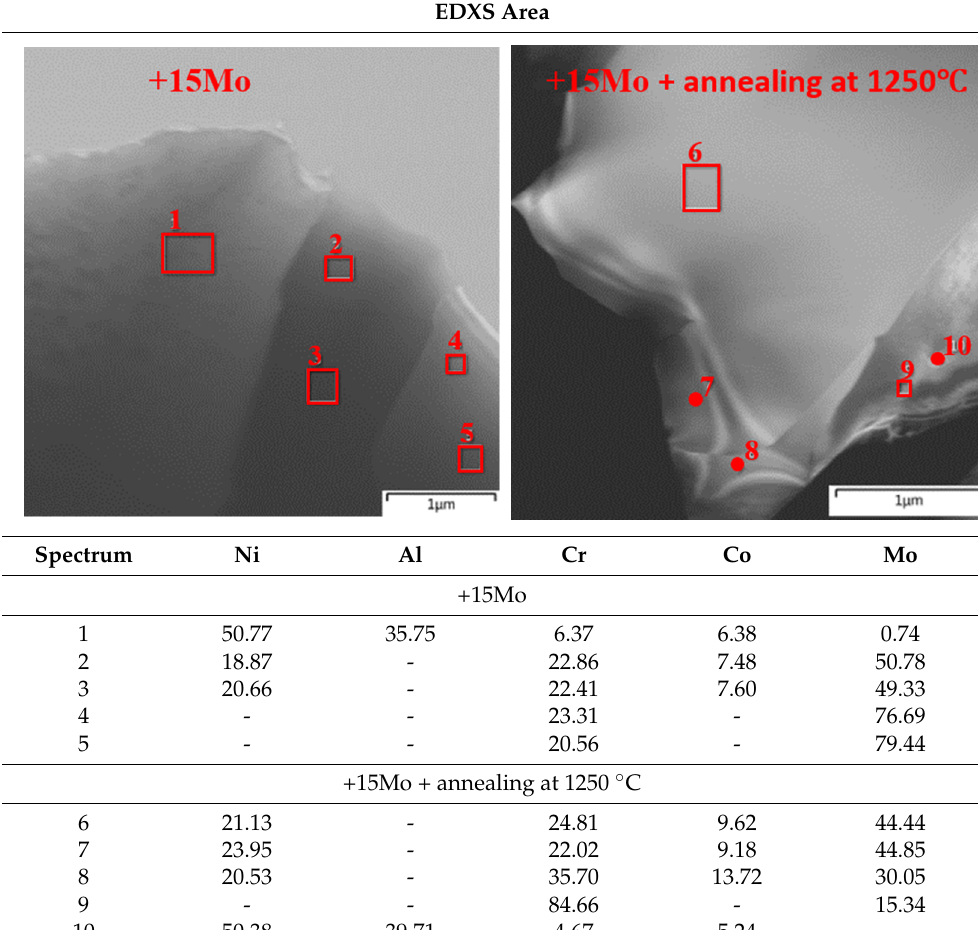
Table 11. The composition of the structural components of the alloy under study, at. %. EDXS Area